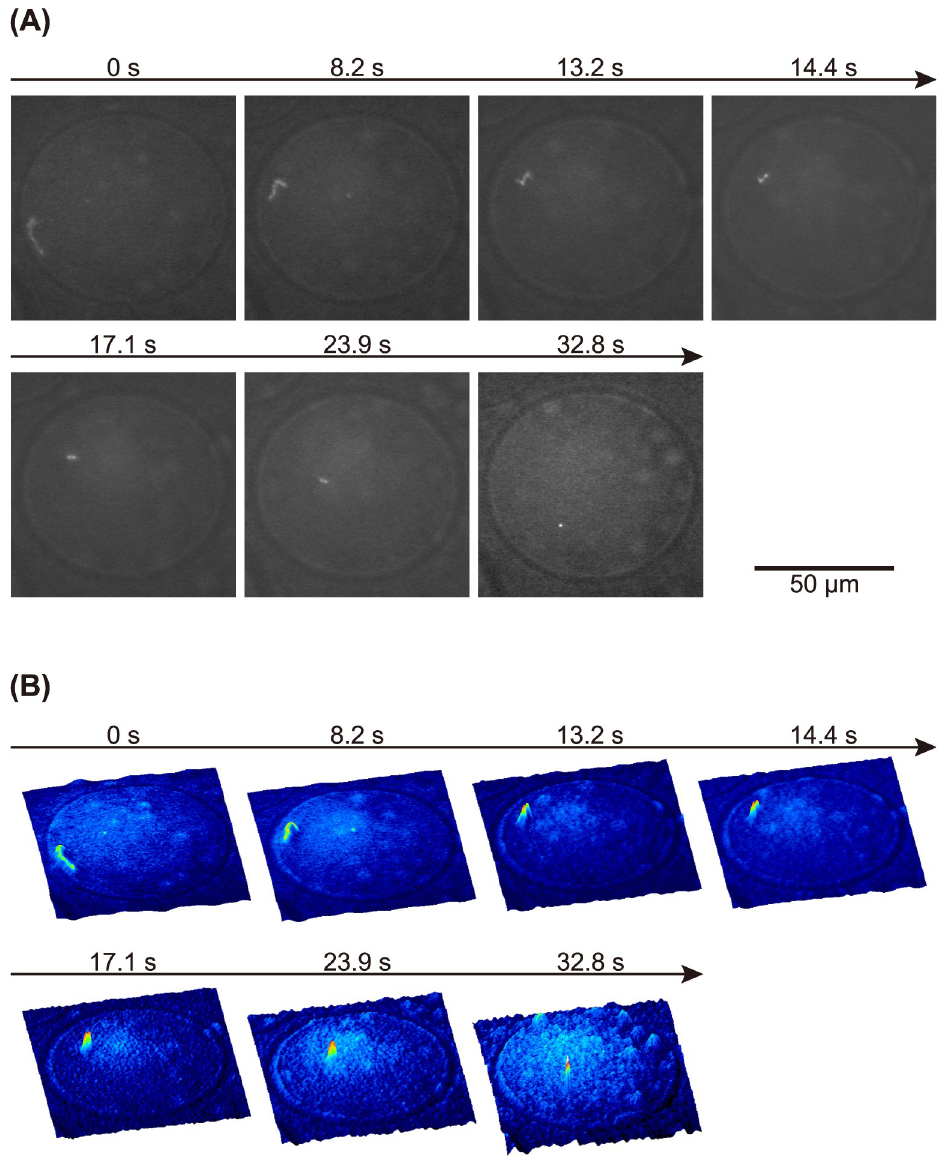
Fig 3. Real-time observation of the folding transition of a single T4 GT7 DNA molecule in a w/w microdroplet. (A) FM images reveal that, under thermal fluctuation, the conformation of a single DNA changes from an elongated coil to a compact globule. The solution composition was similar to that in Fig 1 in the presence of 0.2 mM SPD. The folding transition was generated spontaneously during FM observation of the droplet. (B) Corresponding quasi-3D profiles colored with the fluorescence intensity for the images in